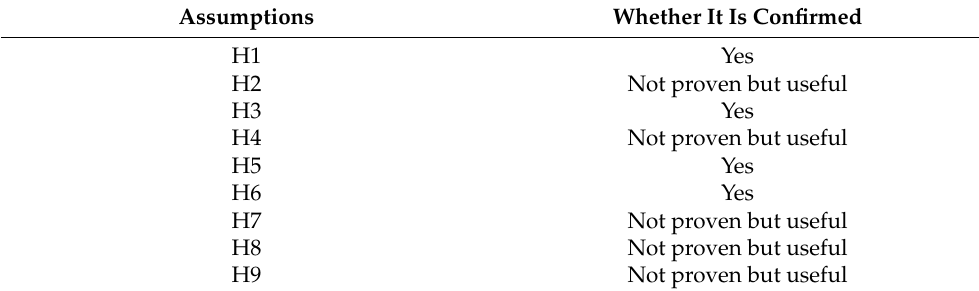
Table 8. Hypothesis confirmation and non-confirmation